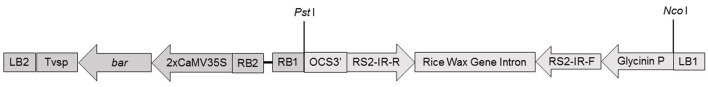
Schematic show of 2 T-DNA regions of transformation construct pMU2T-bar-RS. LB1 and RB1 as well as LB2 and RB2, T-DNA left border and right border regions 1 and 2, respectively; 2x CaMV35S, double CaMV35S promoter; bar, bialaphos resistance gene; Tvsp, soybean vegetative storage protein gene terminator; Glycinin P, soybean glycinin gene promoter; RS2-IR-F and RS2-IR-R, DNA forward and reverse inverted repeat sequences representing partial soybean RS2 gene; OCS 3′, Agrobacterium tumefaciens Octopine gene terminator.